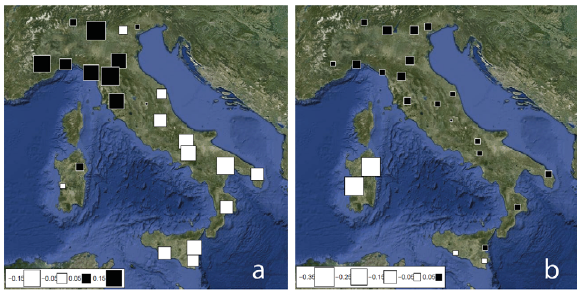
Figure 1. Spatial Principal Component Analysis (sPCA) based on frequencies of Y-chromosome haplogroups. The first two global components, sPC1 (a) and sPC2 (b), are depicted. Positive values are represented by black square; negative values are represented by white squares; the size of the square is proportional to the absolute value of sPC